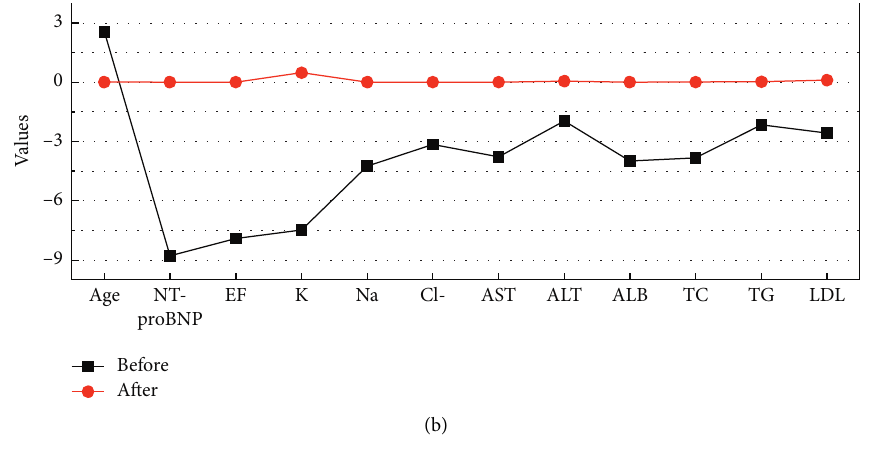
Figure 8: Performance analysis.